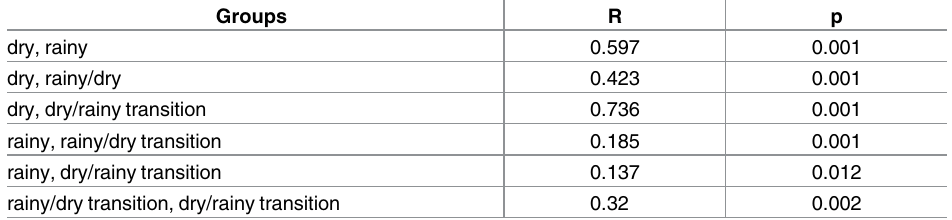
Table 1. ANOSIM of the composition of bird species among hydrocycles in two areas of the Caatinga, namely the Serra da Capivaraand Serra das Confus õ es National Parks, state of Piauı´, Brazil.